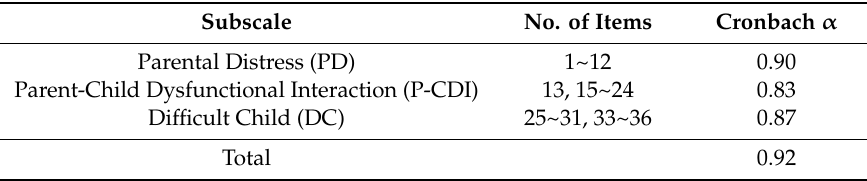
Table 5. The contents of the questionnaire (34 items).